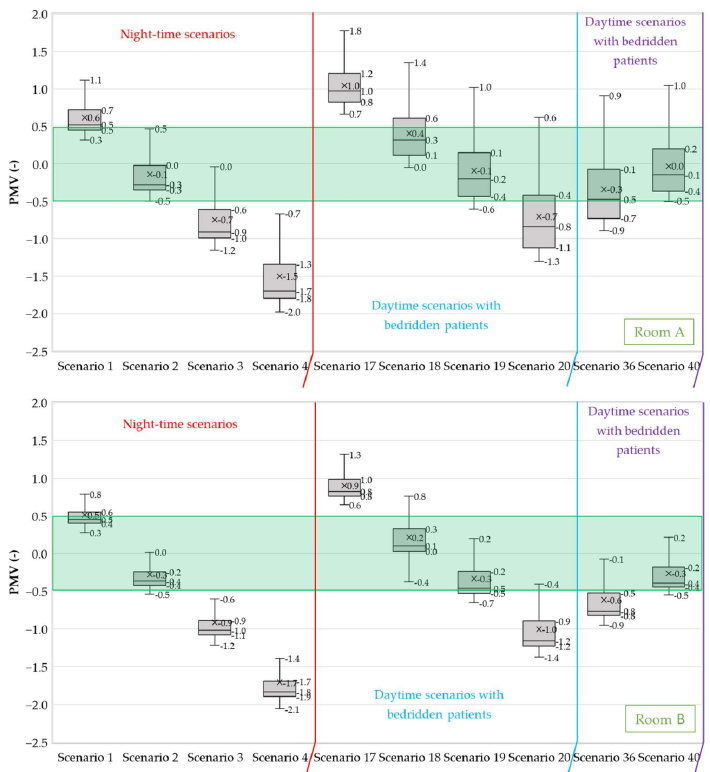
Figure 25. PMV distributions of the different scenarios in winter